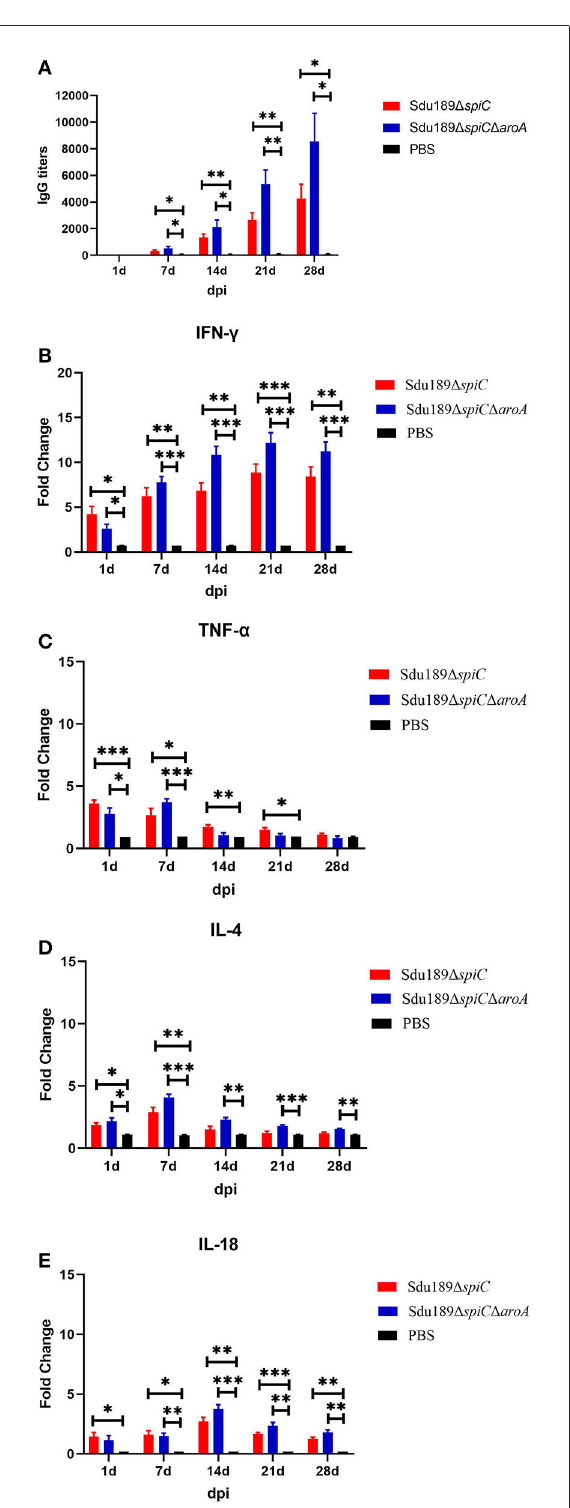
FIGURE4 Humoral and cellular immune responses induced by vaccine candidates. The 6-week-old mice were immunized with 1 × 10 5 CFU of Sdu189 1 spiC or Sdu189 1 spiC 1 aroA , and the serum S .